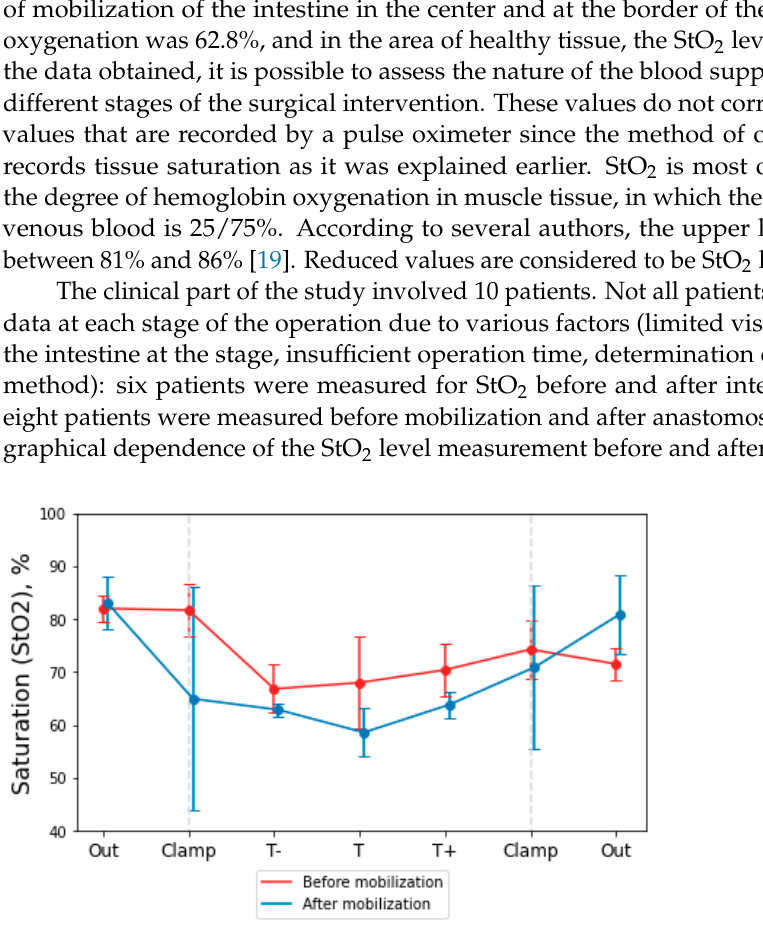
Figure 4. Graphical dependence of StO 2 from the measurement point before and after mobilization of the intestinal area. The dotted lines indicate the points where the surgical clamps were located. Points T − and T + are the borders of the tumor up and down the intestine; T is the center of the